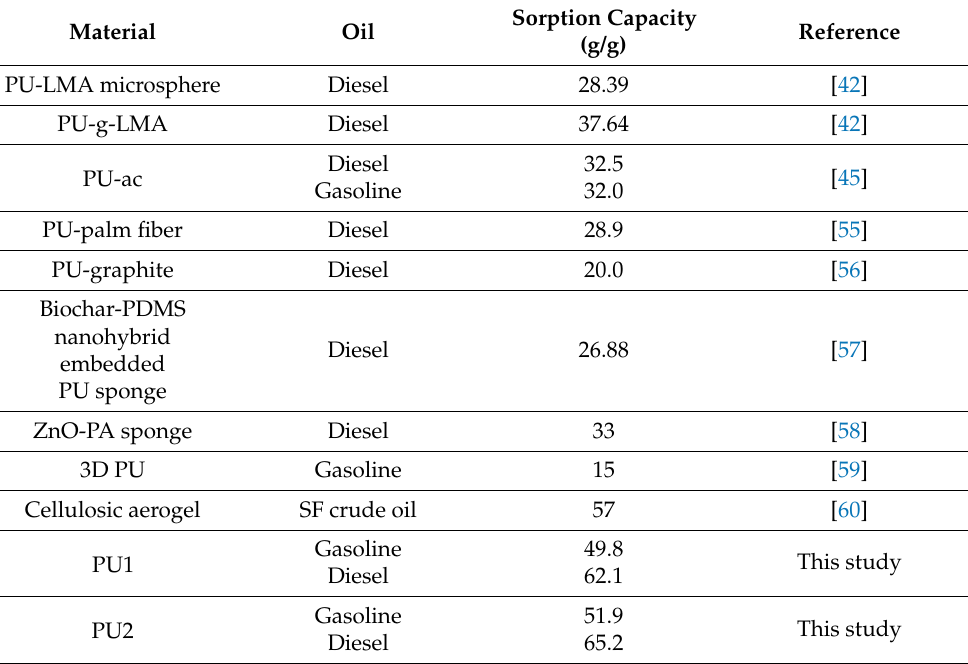
Table 4. A comparison of the total oil sorption capacity (S) with the recent literature data in batch